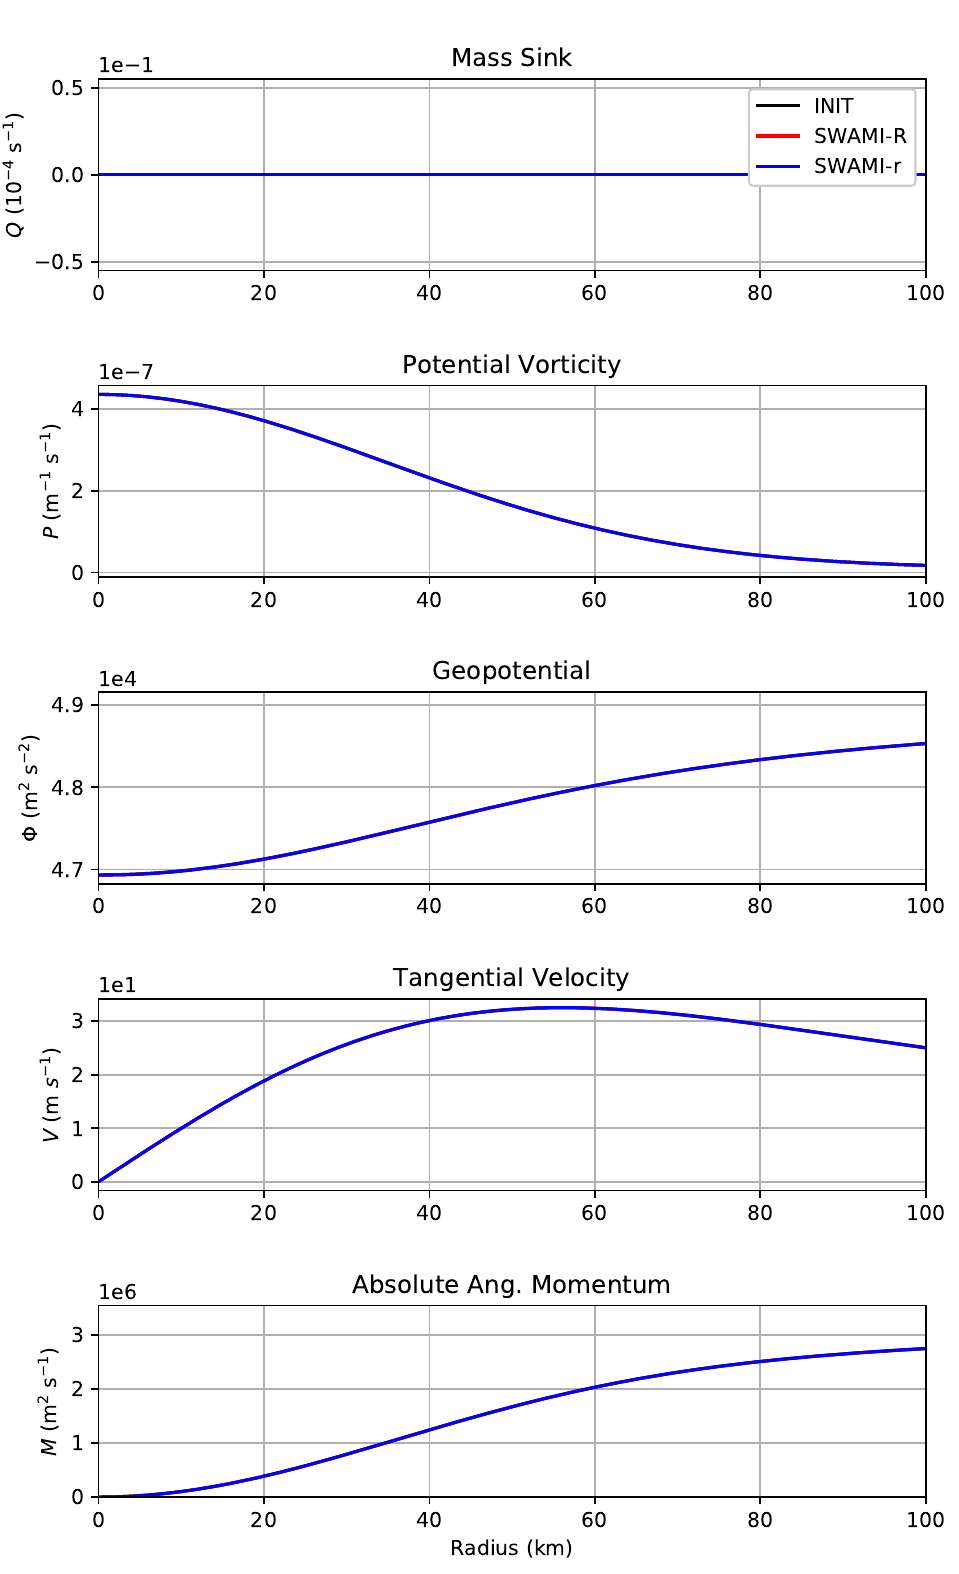
Figure 1. Results of the forced models using a heating amplitude of ˙ θ = 0 K h − 1 . The initial vortex structure is shown along with SWAMI-r and SWAMI-R 12-h forecasts. The initial vortex parameters are Γ = 16,000,000 m s − 1 and b = 50,000